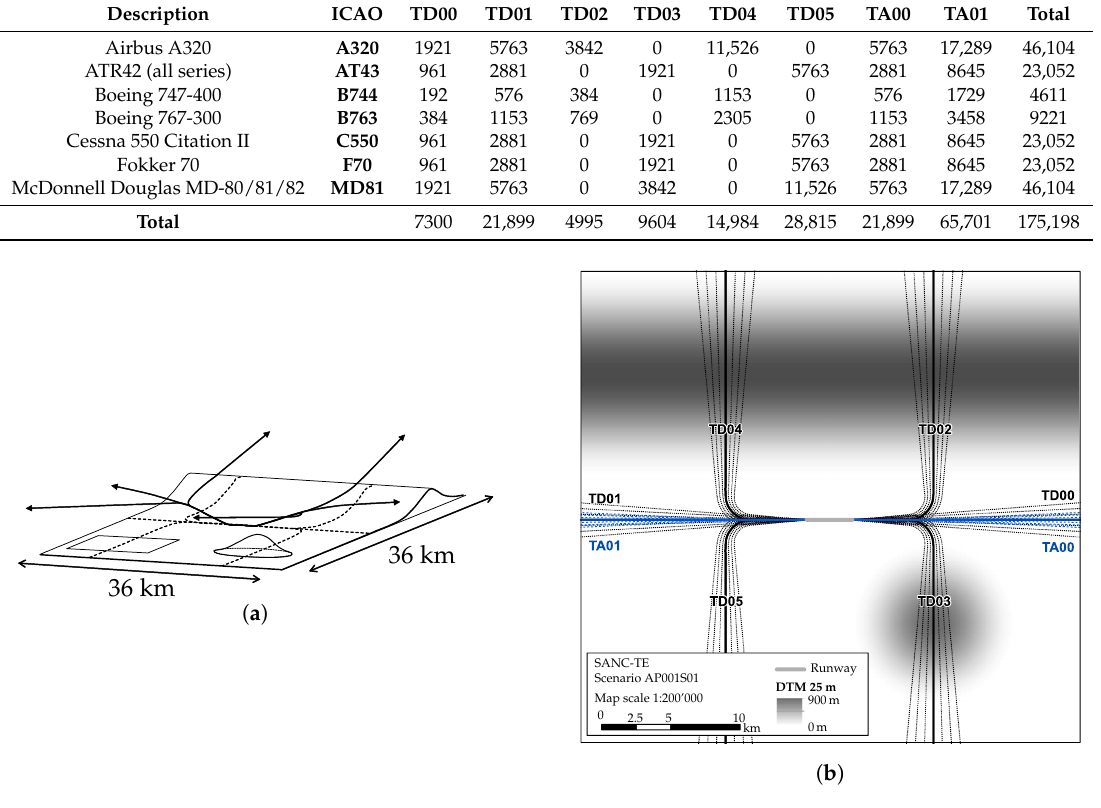
Figure 15. SANC-TE topography and scenario applied in the presented work. ( a ) SANC-TE topography and flight paths, ISO view, from [37]; ( b ) Input data of the SANC-TE scenario. Topography, runway, five departure tracks (solid black lines, TD0X), 2 approach tracks (solid blue lines, TA0X) and their sub-tracks (dotted / dashed) are